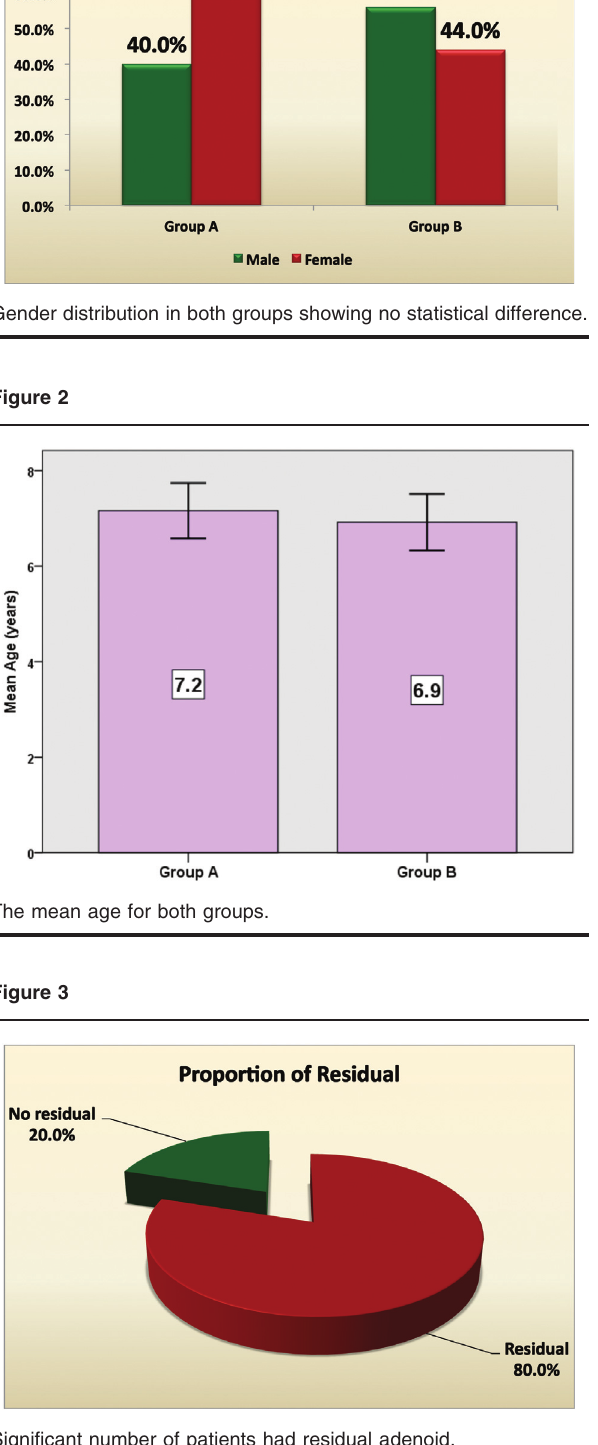
Significant number of patients had residual adenoid.